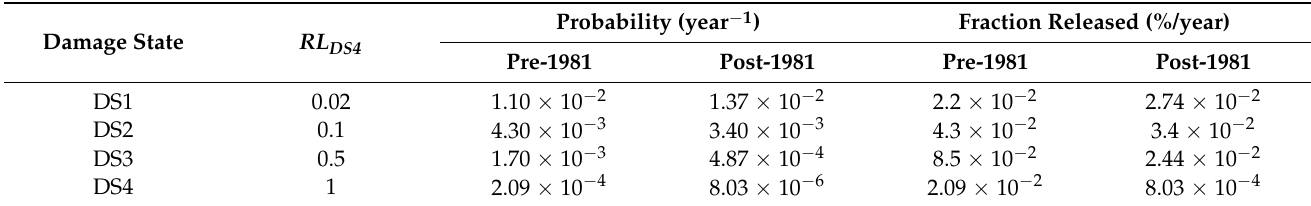
Table 3. Content fractions to be emitted each year due to seismic risk for each damage state and other CGEP framework parameters for L’Aquila.